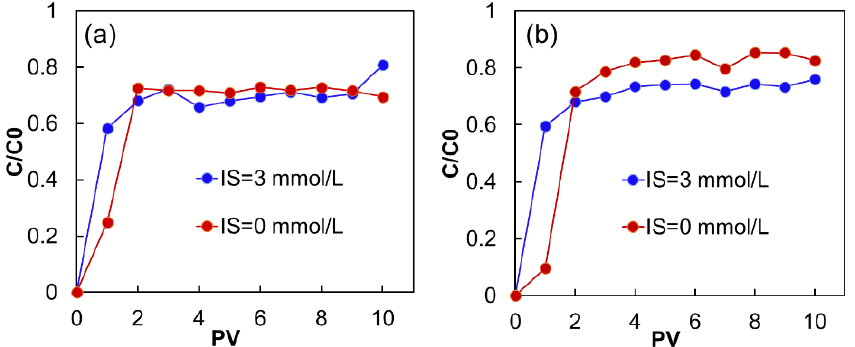
Figure 6. The effect of ion strength on Ni 2+ transport in the sand column. ( a ) In the presence of soil colloids; ( b ) in the absence of soil colloids. The initial concentration of Ni 2+ was 0.6628 mg · L − 1 , different ISs were adjusted with NaNO 3 , the concentration of soil colloids was 220 mg · L − 1 ). Table 3. Results of the Ni 2+ transport in the sand column with different conditions.